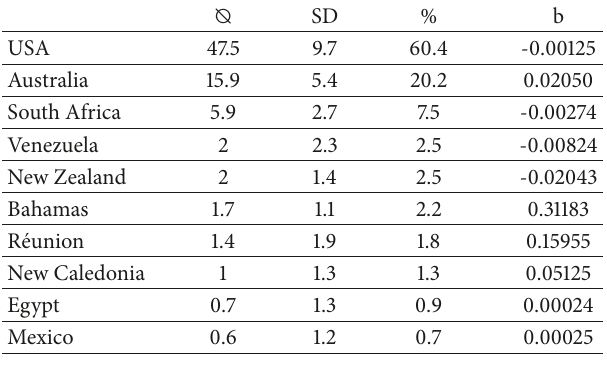
Table 1: Annual average shark bites and slope of the corresponding bite rate regression model for the top ten countries between 2000 and 2016. … : average annual bite counts; SD: standard deviation; %: average annual percentage; b: slope of linear model y i = a + bx i (see “Methods” for further explanation).